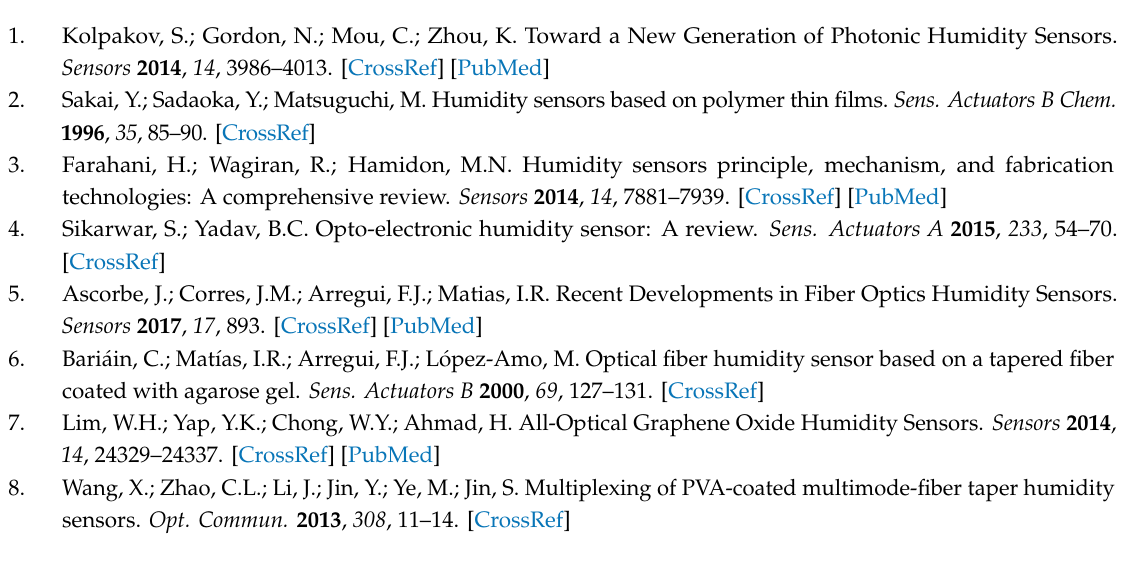
Figure S1: Schematic presentation of the structures of multiblock copolymer with branched macromolecular architecture comprised of poly(N,N-dimethyl acrylamide) (PDMA) and poly(ethylene oxide) (PEO) segments; Figure S2: Calculated transmittance and reflectance at a wavelength of 600 nm of transparent thin film with a refractive index of 1.5 deposited on glass substrate as a function of thickness; Figure S3: Calculated transmittance and reflectance at wavelengths of 600 nm (left) and 800 nm (right) of transparent thin film with a refractive index of 1.5 deposited on glass substrate and silicon wafer as function of thickness; Figure S4: CIE color coordinates of a 5-layer Bragg stack top-covered with 300 nm polymer film exposed to denoted levels of relative